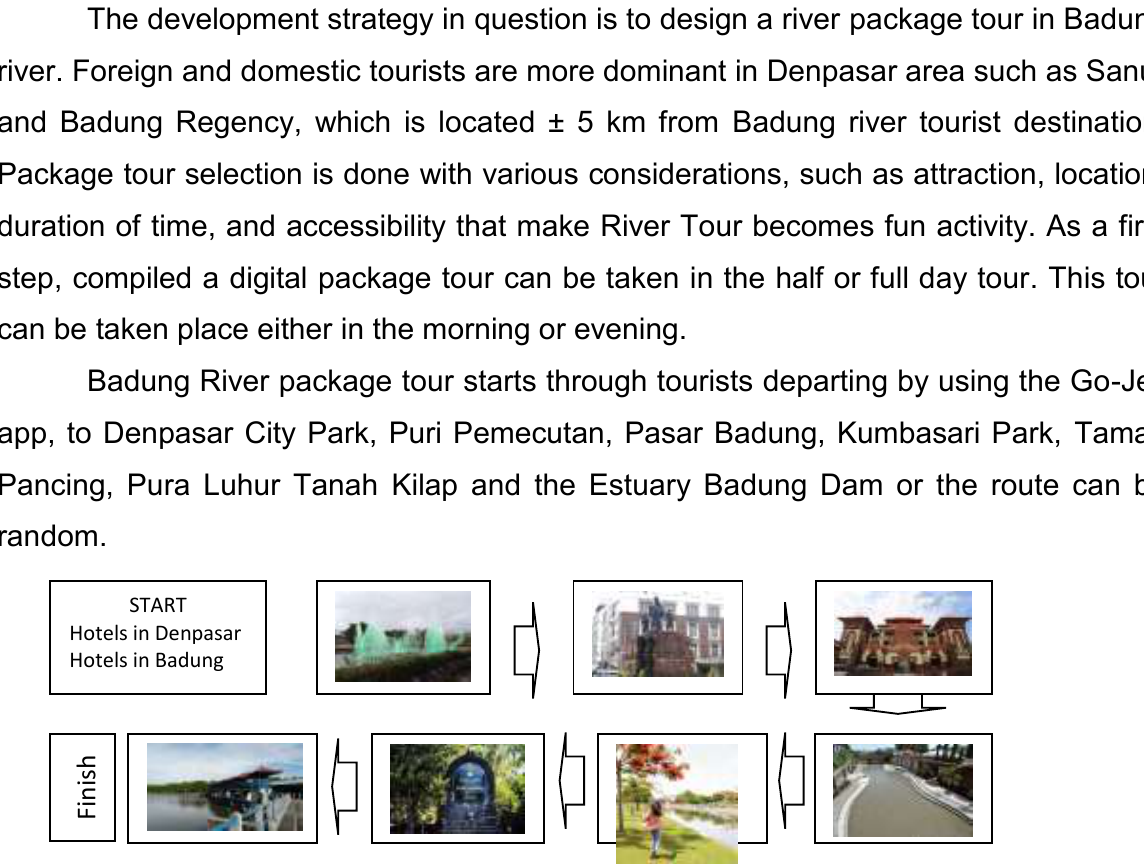
Figure 2. Badung River Package